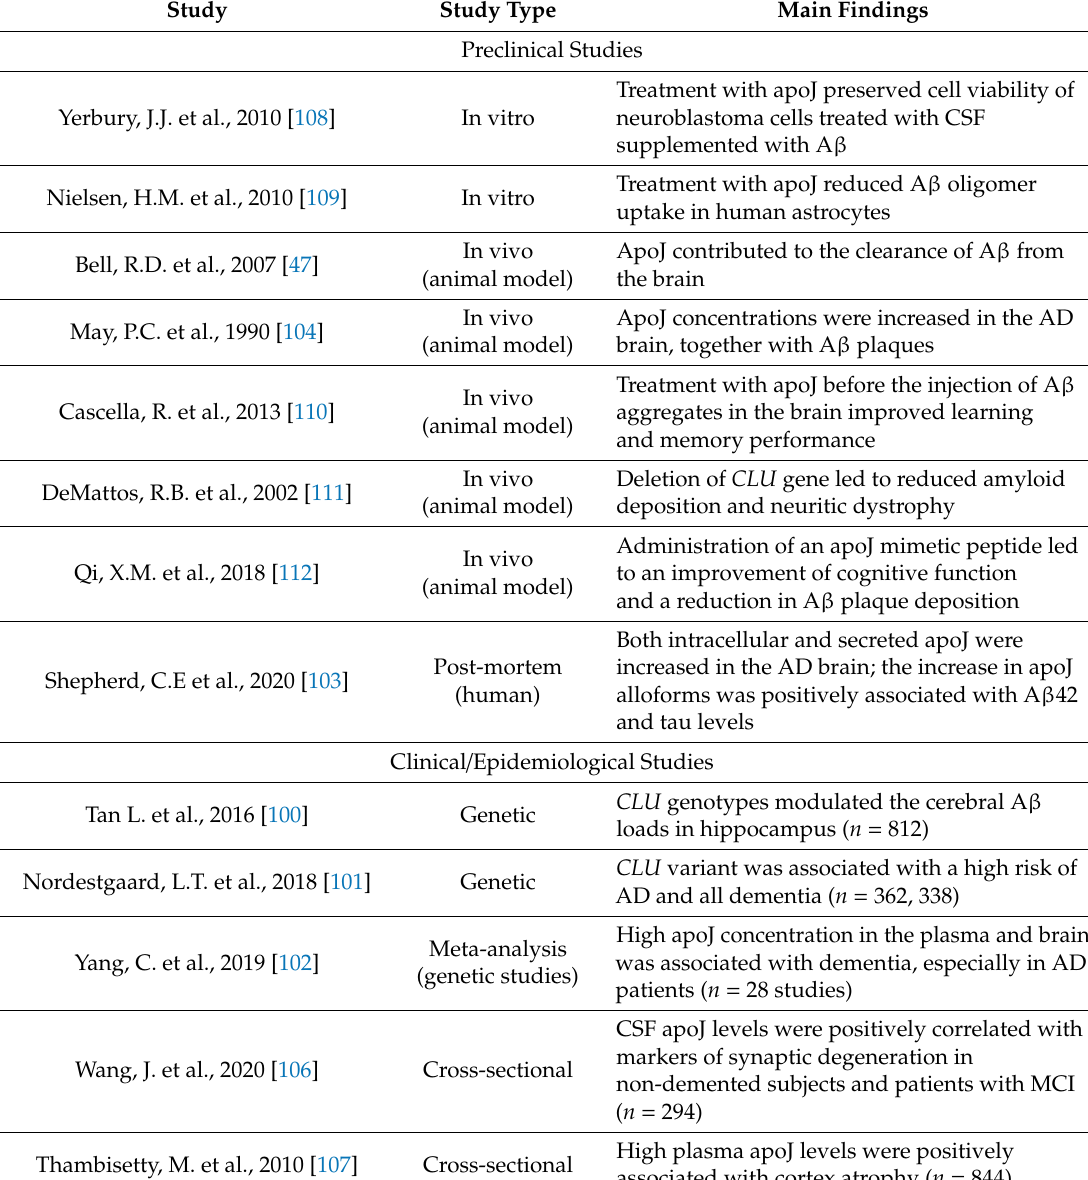
Table 3. Selection of preclinical and clinical evidence supporting the role of apolipoprotein J (apoJ) in protecting from Alzheimer’s disease